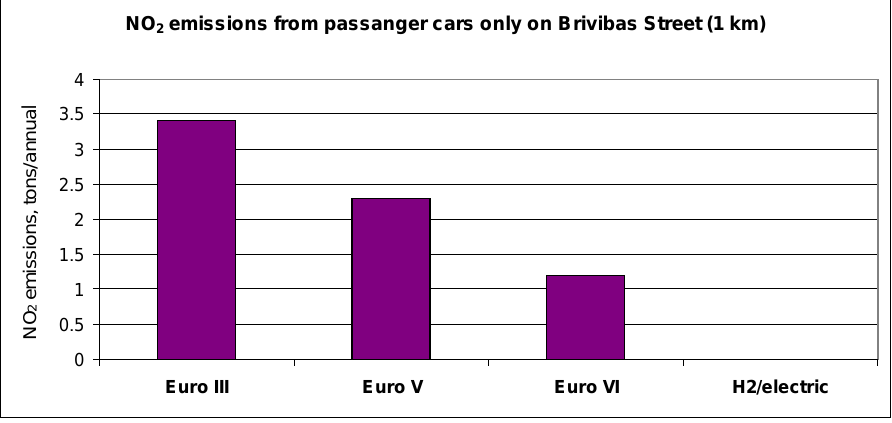
Fig. 3. Calculated annual NO 2 emissions from passenger cars driving 1 km on Br ī v ī bas Street, Riga, 2011 ‒